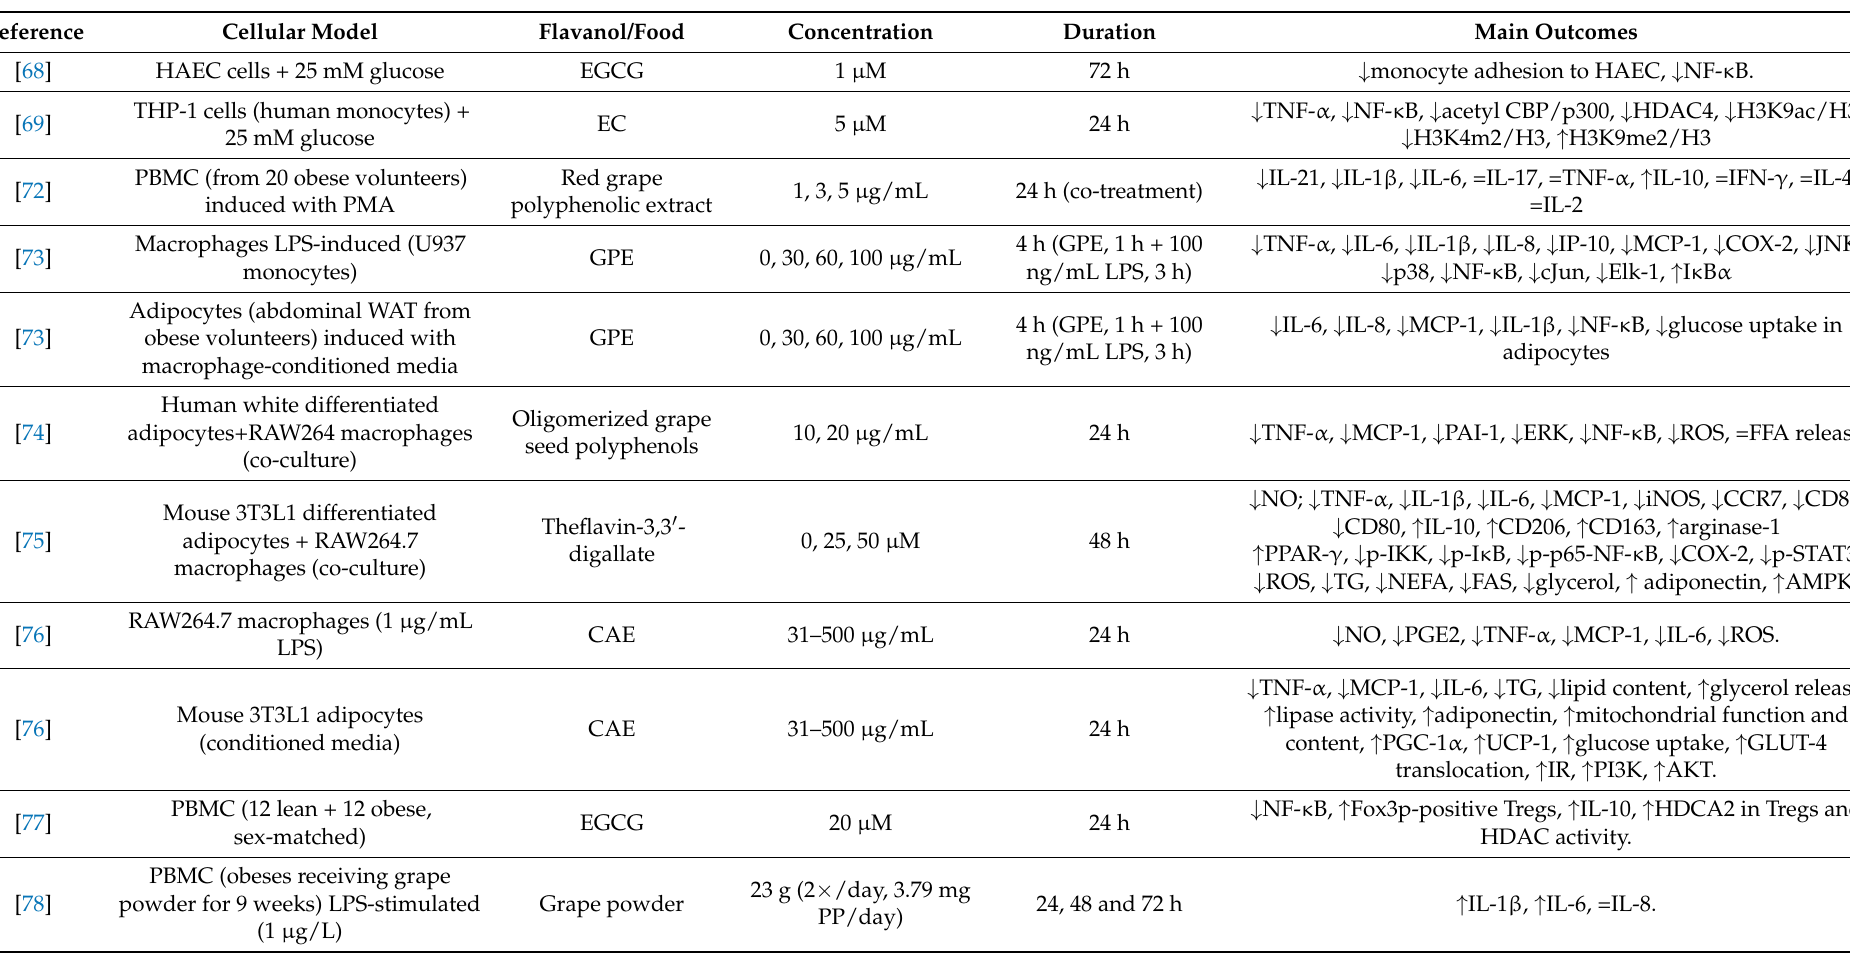
Table 1. Summary of the most relevant effects of flavanol and flavanol-rich product treatments on immunity, inflammation and metabolism in cultured cells a .